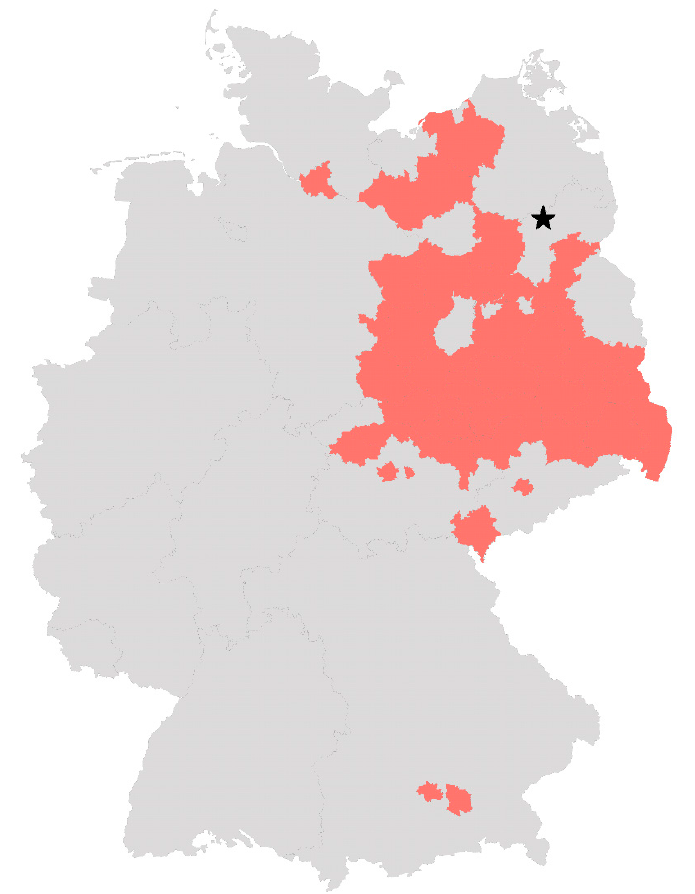
Figure 1. German districts with confirmed WNV infections in birds, horses and humans. Districts that have reported at least one case of WNV infection in birds, horses or humans by 12 November 2022 according to the TierSeuchenInformationsSystem (TSIS) and the European Centre for Disease prevention and control (ECDC) are colored in red. The star marks the collection place of Ae. punctor larvae and pupae used in this study. The map was created with Microsoft Excel.